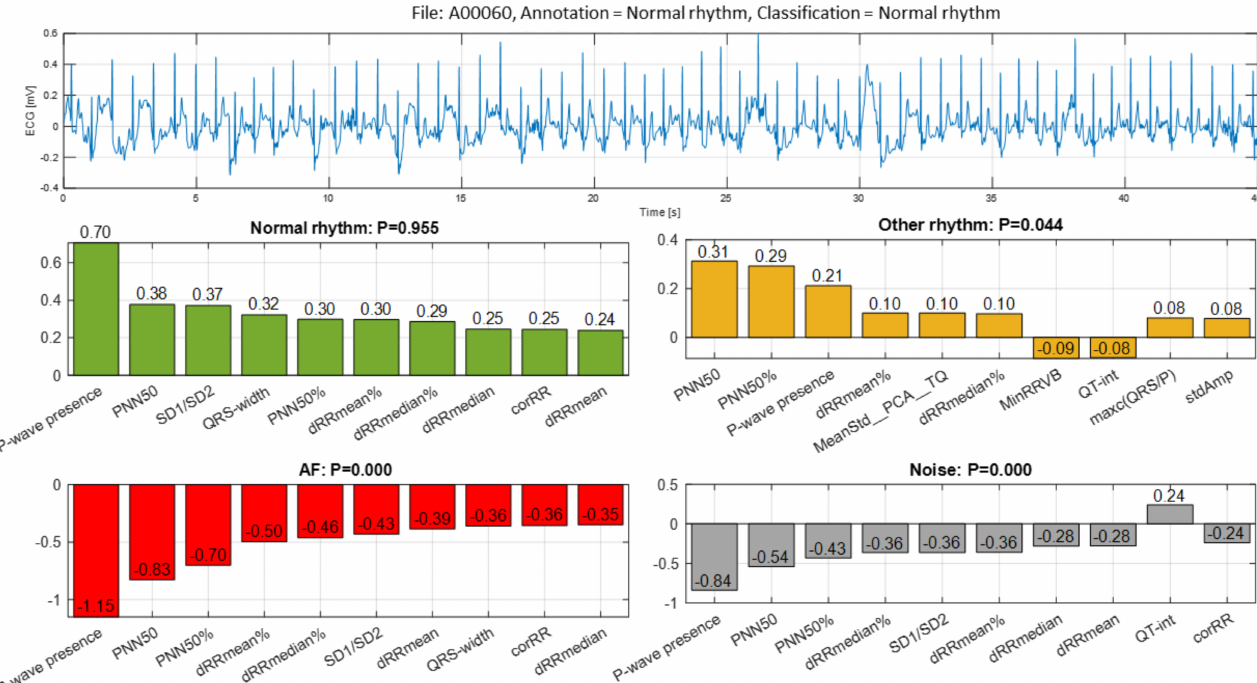
Figure 11. ECG example (file A00060) of correctly classified Normal rhythm. The single-lead ECG strip is representative to sinus rhythm corrupted with baseline and high-frequency artifacts due to poor electrode contact or/and patient’s movements. No discernible repeating P-waves are present, and RR intervals seem ‘irregularly irregular’. The barplots represent the Case Feature Importance of the top-10 ranked features, which maximally contribute to the output classification probability ( p ) of four rhythms. The ECG strip is definitively detected as Normal rhythm (P = 0.955) based on HRV features, P-wave presence and QRS-width by DenseNet-3@128-32-4